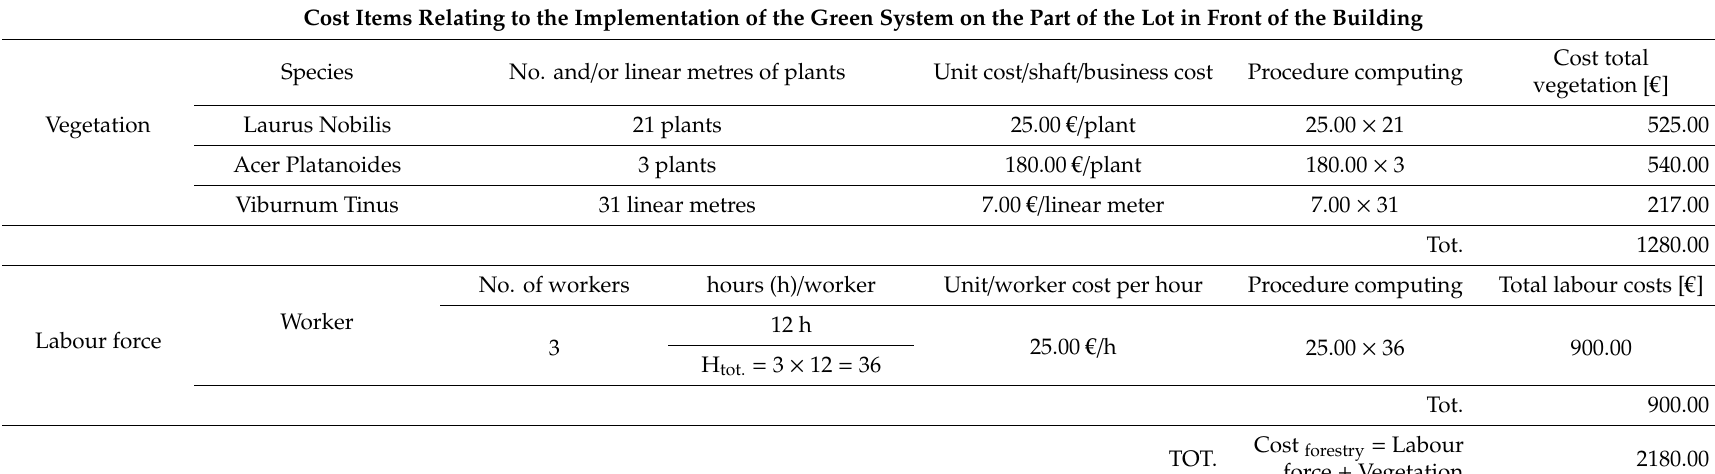
Table 9. Estimation of costs related to urban forestation